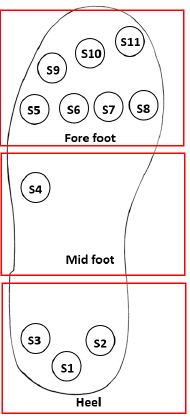
Figure 10. Pressure sensor layout in the sole.